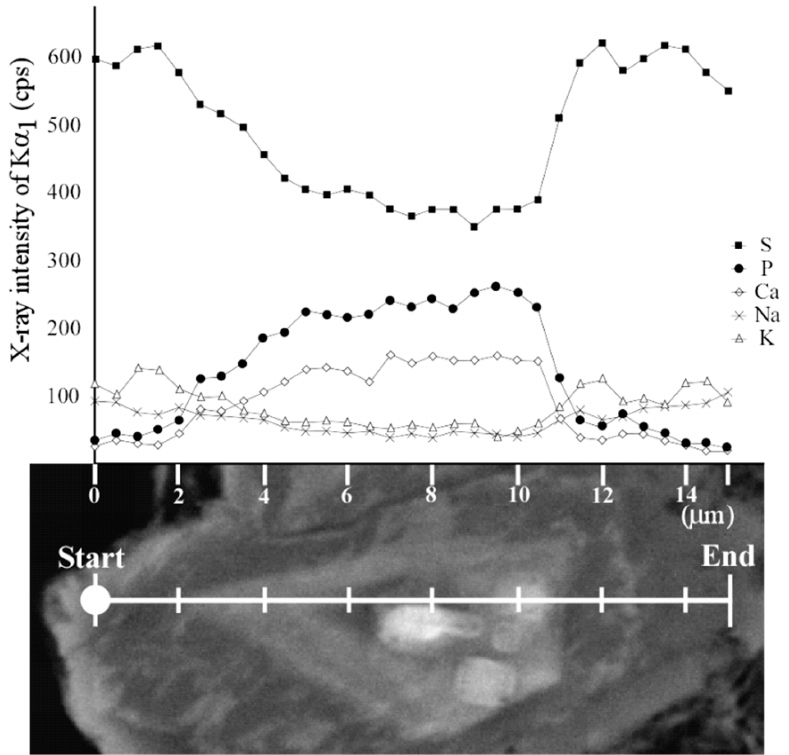
Figure 4. EDS line scan profile with the backscattered electron images (BEI) image of the woodhouseite-bearing alunite crystal. The compositionally zoned crystal is contained in the grain of ONTK-VA-012 in Table 2 and Figure 5b.